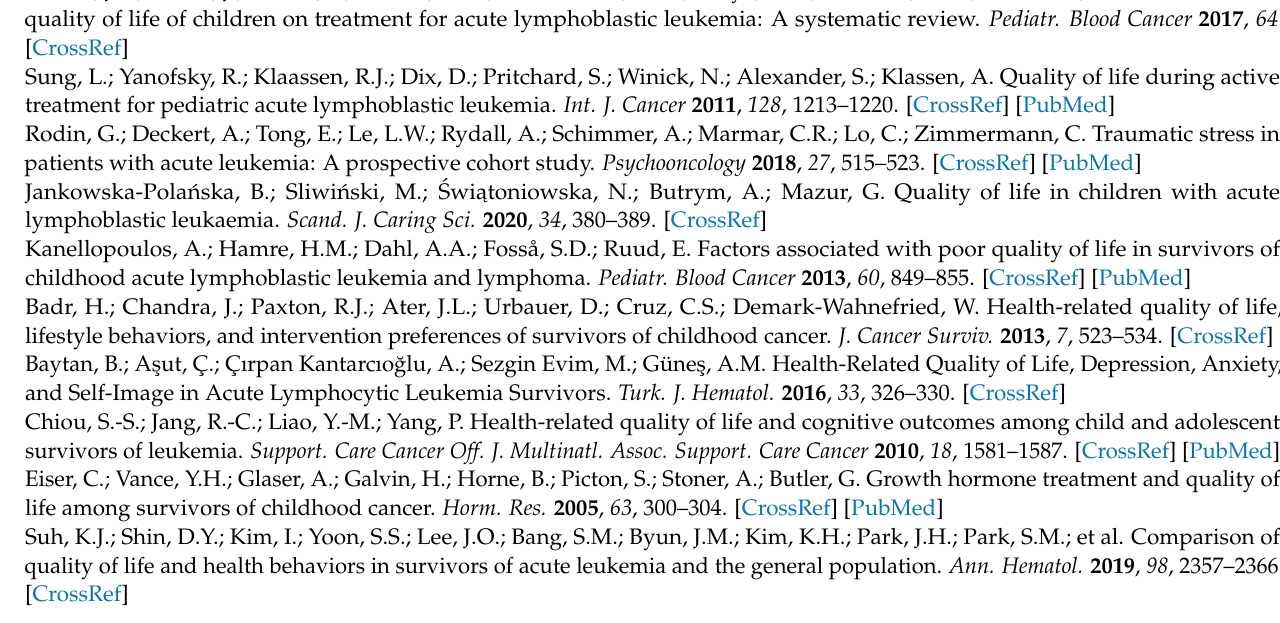
covariates used for the adjusted models. Supplementary Table S2: Descriptive statistics SF-12 and IOC-CS. Supplementary Table S3: Distribution of predictors of interest by covariates. Supplementary Tables S4–S8: Univariate and additional (NCI risk and CRT)